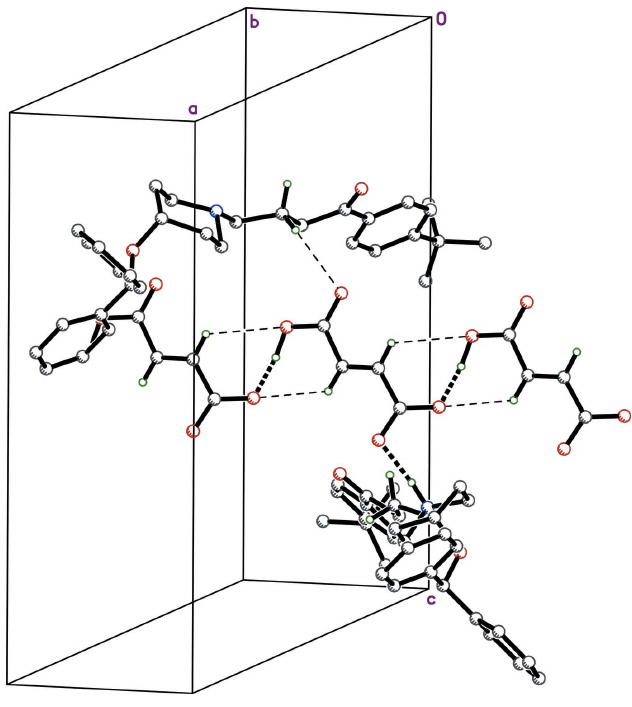
Figure 6 Fingerprint plots of interatomic contacts for I (major disorder component only) obtained from a Hirshfeld surface analysis. ( a ) All contacts, ( b ) H (cid:2)(cid:2)(cid:2) H contacts (55% coverage), ( c ) C (cid:2)(cid:2)(cid:2) H/H (cid:2)(cid:2)(cid:2) C contacts (23.5%), ( d ) O (cid:2)(cid:2)(cid:2) H/H (cid:2)(cid:2)(cid:2) O contacts